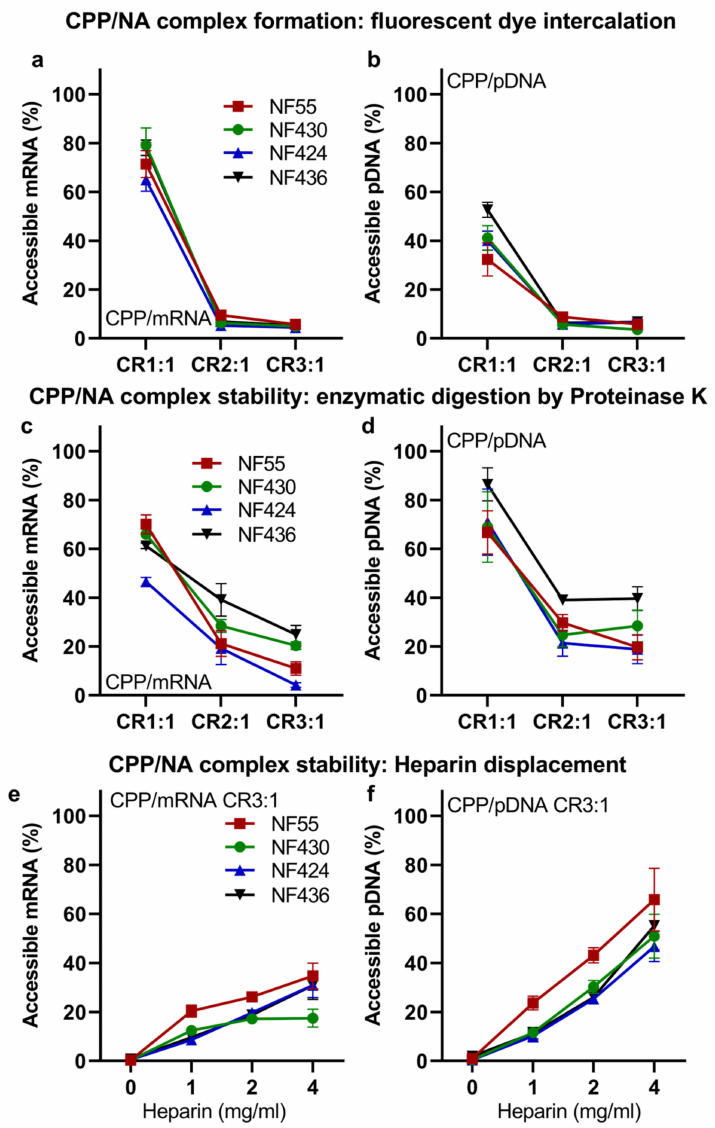
Figure 3. New NF55 analogs form nanoparticles which led to high reporter levels post-transfection both in vitro and in vivo. Complex formation between CPP and ( a ) mRNA or ( b ) pDNA assessed by the accessibility of nucleic acid to fluorescent nucleic acid binding dye after the addition of CPPs. CPP/NA complexes formed at charge ratios (CR) 1:1, 2:1, and 3:1 with CPPs in excess. Free nucleic acid at the same concentration was used as the controls (100%). The stability of pre-formed ( c ) CPP/mRNA and ( d ) CPP/pDNA nanoparticles to enzymatic digestion by proteinase K. The stability of pre-formed ( e ) CPP/mRNA and ( f ) CPP/pDNA nanoparticles to heparin